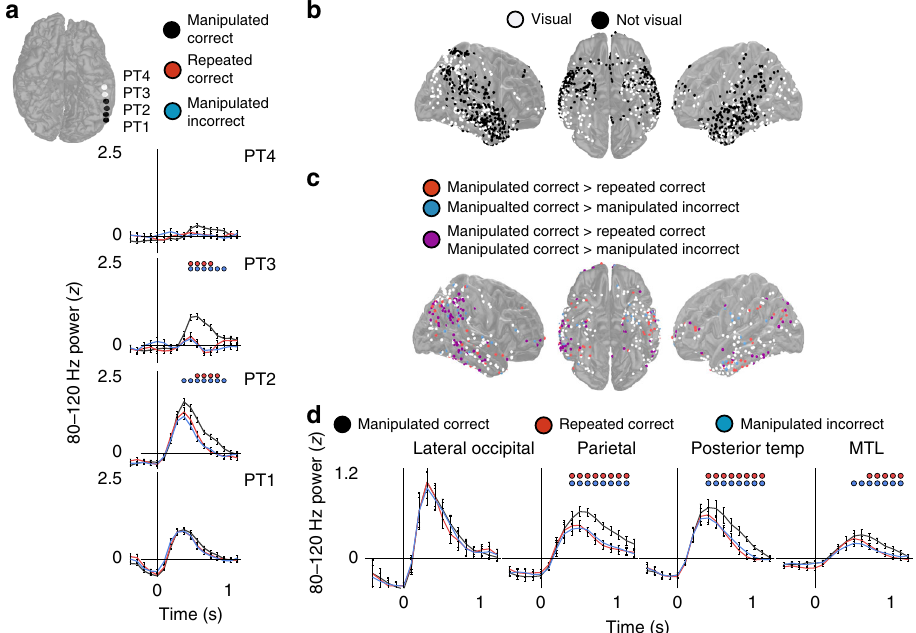
Fig. 3 Increases in 80 – 120 Hz power in visual association cortex and MTL re fl ect differences between present and remembered visual experience. a Time series of 80 – 120 Hz power for a set of posterior temporal electrodes in an example participant during 142 manipulated correct (black), 122 manipulated incorrect (blue), and 82 repeated correct (red) recognition trials (200 ms sliding windows, 50% overlap; image appears at t = 0). Blue and red dots indicate signi fi cant differences in 80 – 120 Hz power between manipulated correct and manipulated incorrect and repeated correct condition, respectively ( p < 0.05, permutation procedure). b All electrodes across all participants demonstrating signi fi cant increases in 80 – 120 Hz power from baseline (white; p < 0.05, permutation procedure corrected for multiple comparison within each electrode). c All visually responsive electrodes in each participant (white) demonstrating signi fi cant increases in 80 – 120 Hz power for the manipulated correct compared to the manipulated incorrect (blue), manipulated correct compared to the repeated correct (red), or both (purple; p < 0.05, permutation procedure corrected for multiple comparison within each electrode). d Time courses of 80 – 120 Hz power for the manipulated correct, manipulated incorrect, and repeated correct conditions across 6 LOC, 8 PAR, 10 PT, and 10 MTL participants during the recognition period (200 ms sliding windows, 50% overlap; image appears at t = 0). Blue and red dots indicate signi fi cant differences in 80 – 120 Hz power between manipulated correct and manipulated incorrect and repeated correct condition, respectively ( p < 0.05, permutation procedure). All error bars indicate standard error of